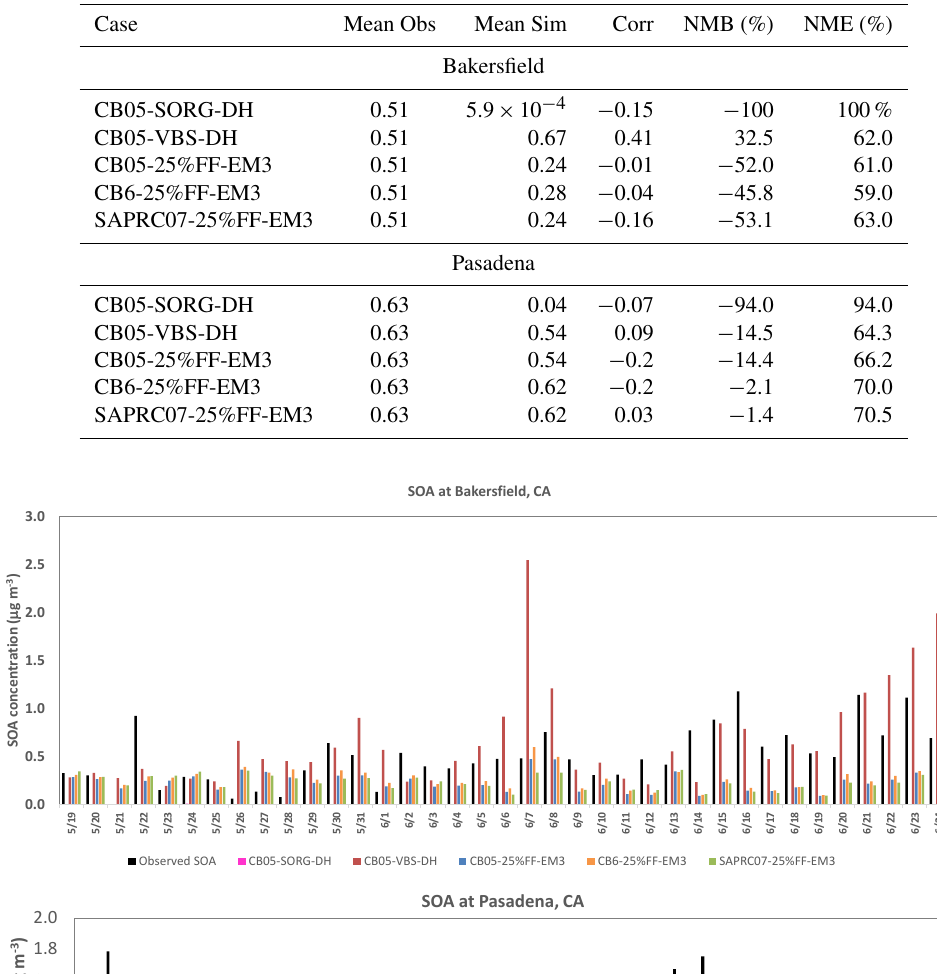
Table 6. Statistics for evaluation at Bakersfield and Pasadena sites. A bar chart of daily average obs vs. sim values can be found in Fig. 4.